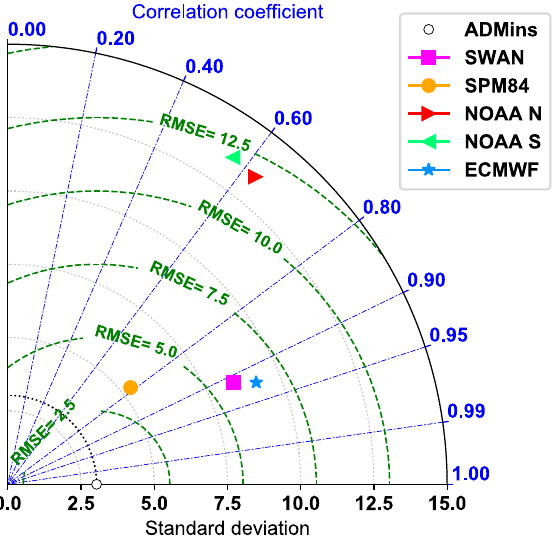
Figure 13. Taylor diagram of the performance of each of the considered models.